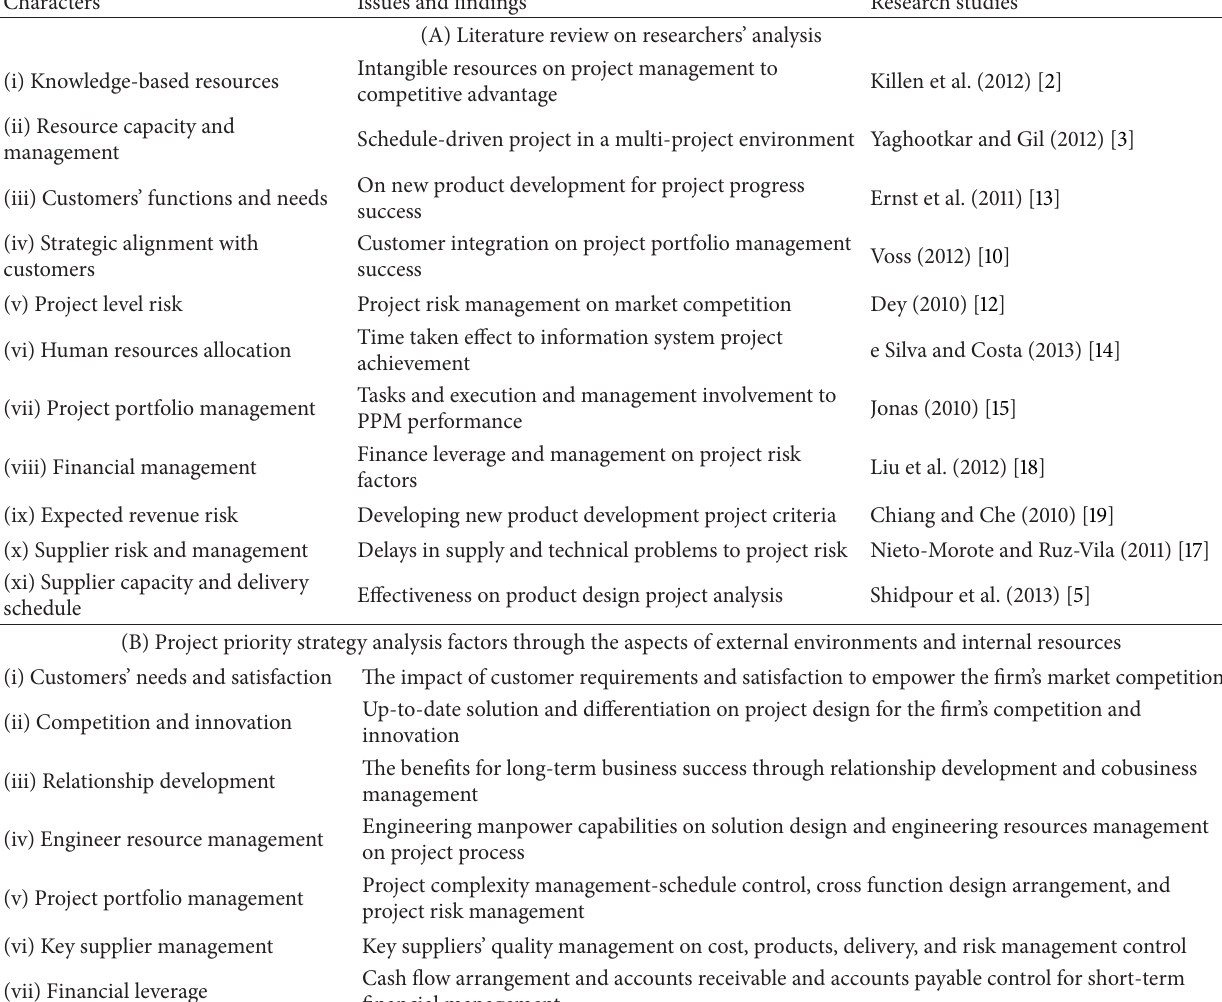
Table 3: Characters on bridging the gaps between previous research studies and our empirical case